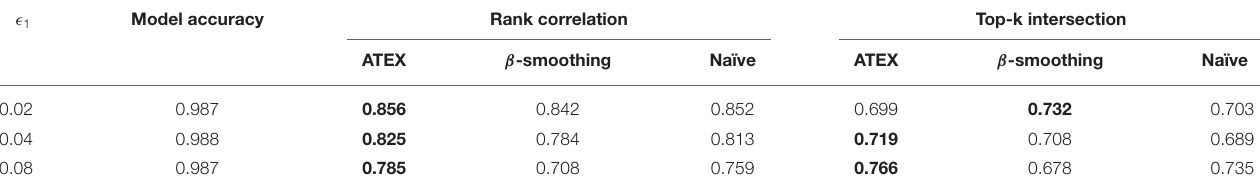
TABLE 4 | Defense against targeted explanation manipulation on